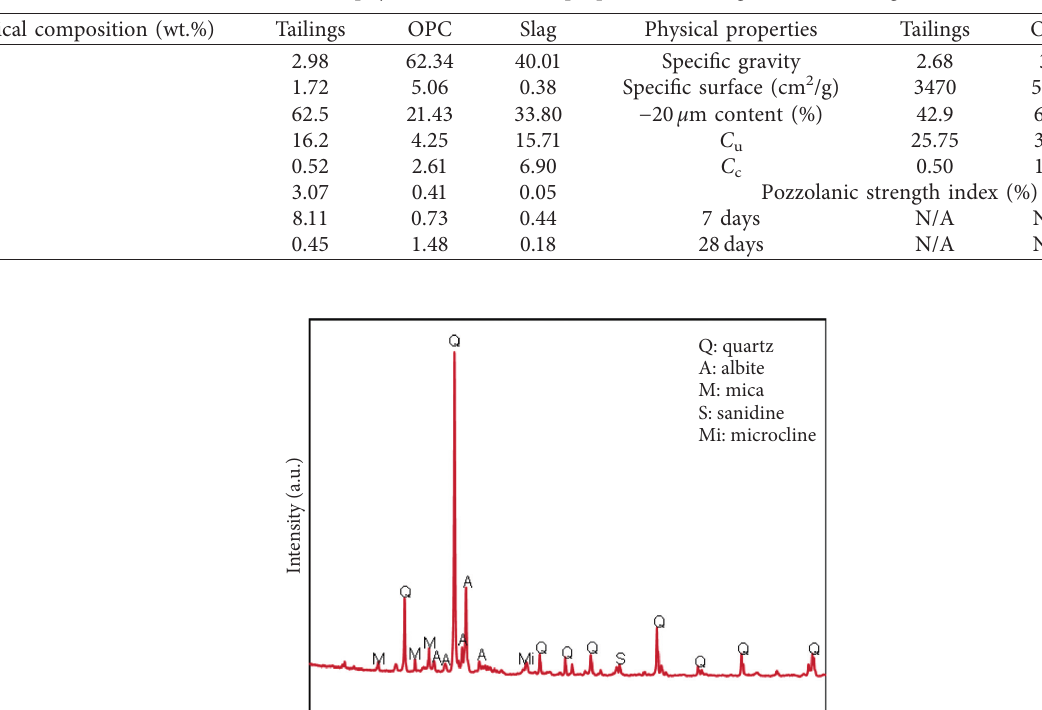
Figure 1: Particle size distribution curves for tailings, OPC, and Table 1: Main physical and chemical properties of tailings, OPC, and slag.